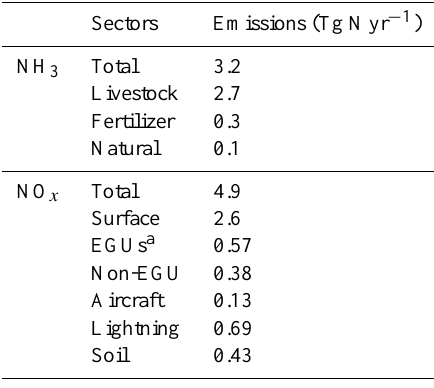
Table 2. NO x and NH 3 emissions in the contiguous US in 2010.